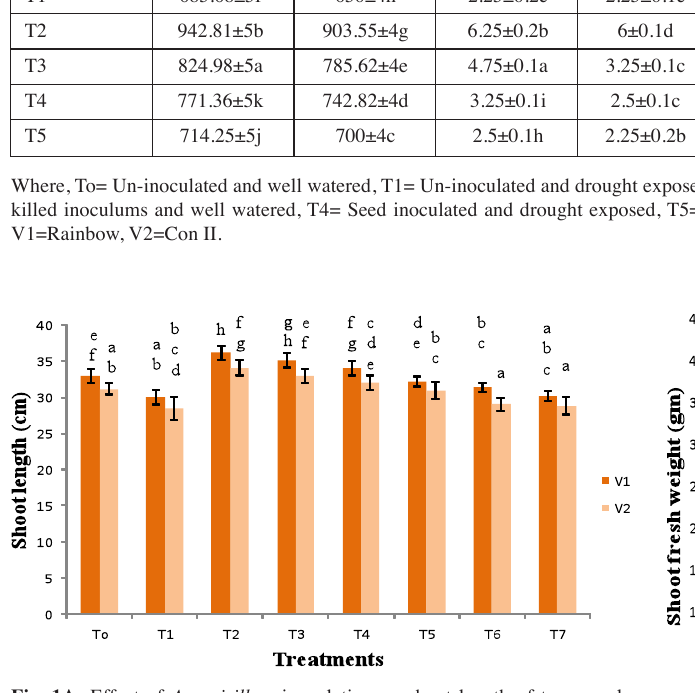
Fig. 1A: Effect of Azospirillum inoculation on shoot length of two canola varieties (v1 and v2) grown under drought stress. Where, To = Un-inoculated and well watered, T = Un-inoculated and drought exposed, T2 = Seed inoculated and well watered, T3 = Rhizosphere inoculated and well watered, T4 = Seed inoculated with heat killed inoculums and well watered, T5 = Seed inoculated and drought exposed, T6 = Rhizosphere inoculated and drought ex- posed, T7 = Seed inoculated with heat killed inoculums and drought exposed. And V1 = Rainbow, V2 = Con II.